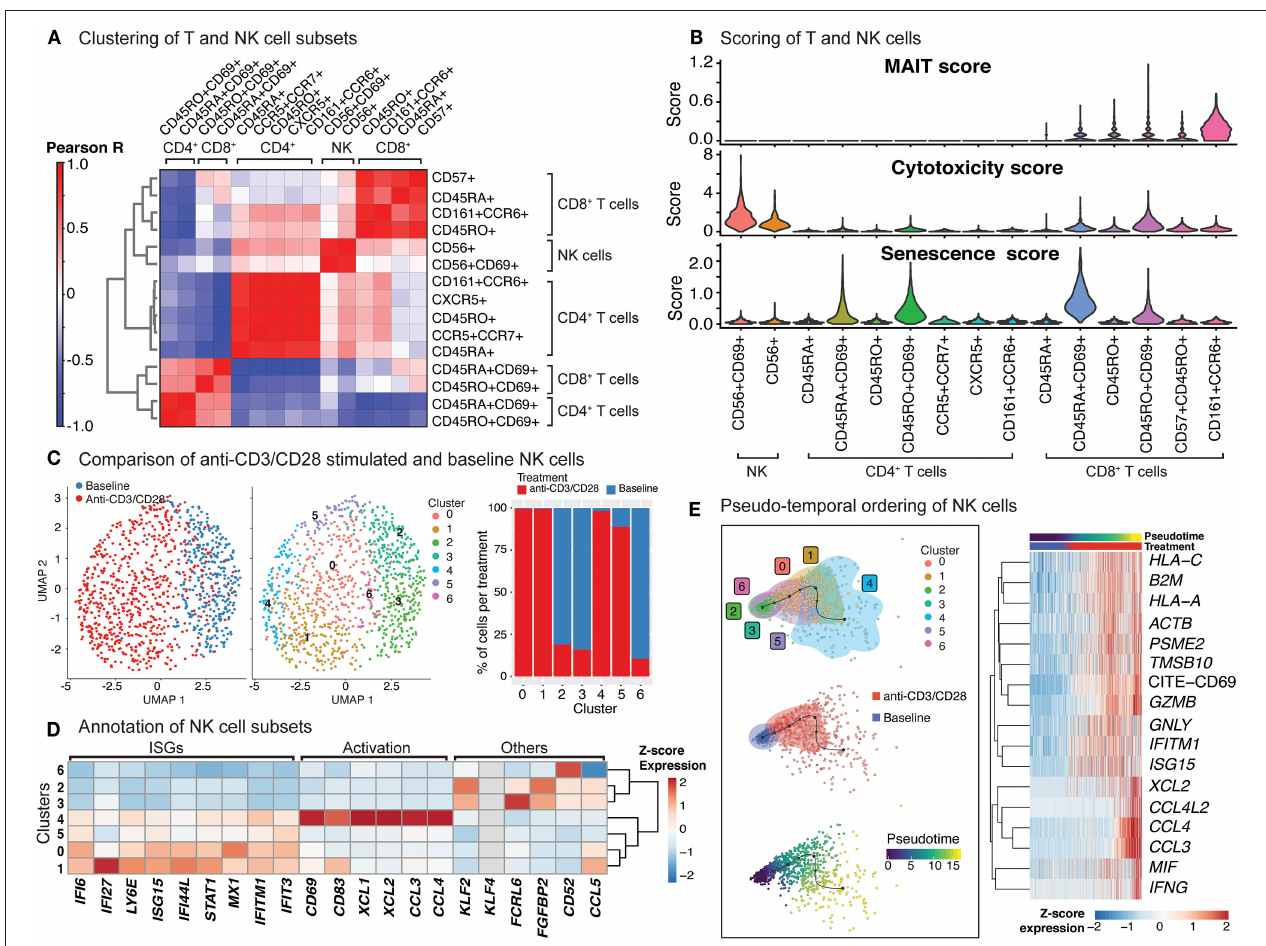
FIGURE 4 | Indirect activation of NK cells. (A) Baseline and activated T cell and NK cell subsets were clustered together and the top 50 principal components were extracted. Pearson correlation values were then computed for each baseline and activated cell type and summarized in the heatmap. (B) Scoring of all T and NK cells was determined using transcripts associated with MAIT cell identity, cytotoxicity, and senescence (genes used are shown in Supplementary Table 3 ). (C) Clustering of NK cells at baseline, and anti-CD3/CD28 conditions identifies 7 different subgroups (middle). In particular, anti-CD3/CD28-stimulated NK cells clustered distinctly from those at baseline (left). Distribution of NK cells in each cluster across three conditions (left). Note the enrichment of activated NK cells in clusters 0, 1, 4, and 5. (D) Heatmap of interferon stimulated genes (ISGs), activation-associated genes, and others used to annotate the NK sub-clusters. Heatmap values represent the average scaled expression of each gene for cells in the corresponding cluster. (E) (left) Pseudotime trajectory inference of NK cells at baseline and anti-CD3/CD28 conditions. (right) Genes and proteins whose expression patterns change with pseudotime in NK